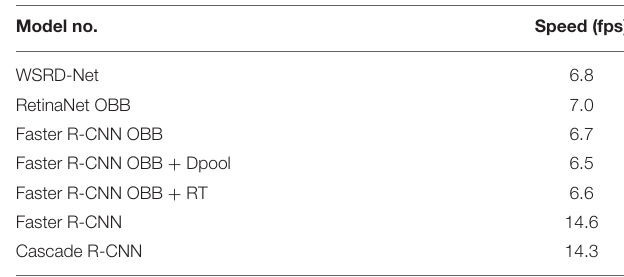
TABLE 3 | Speed comparison with the state-of-the-art oriented detection methods and horizontal detection models. Model